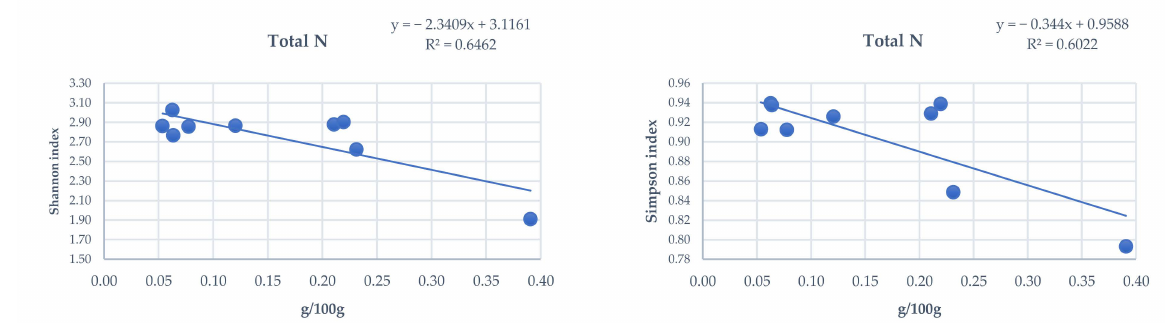
Figure 7. Relationship between the total N content of the soil and the Shannon diversity ( left ) and Simpson uniformity ( right )